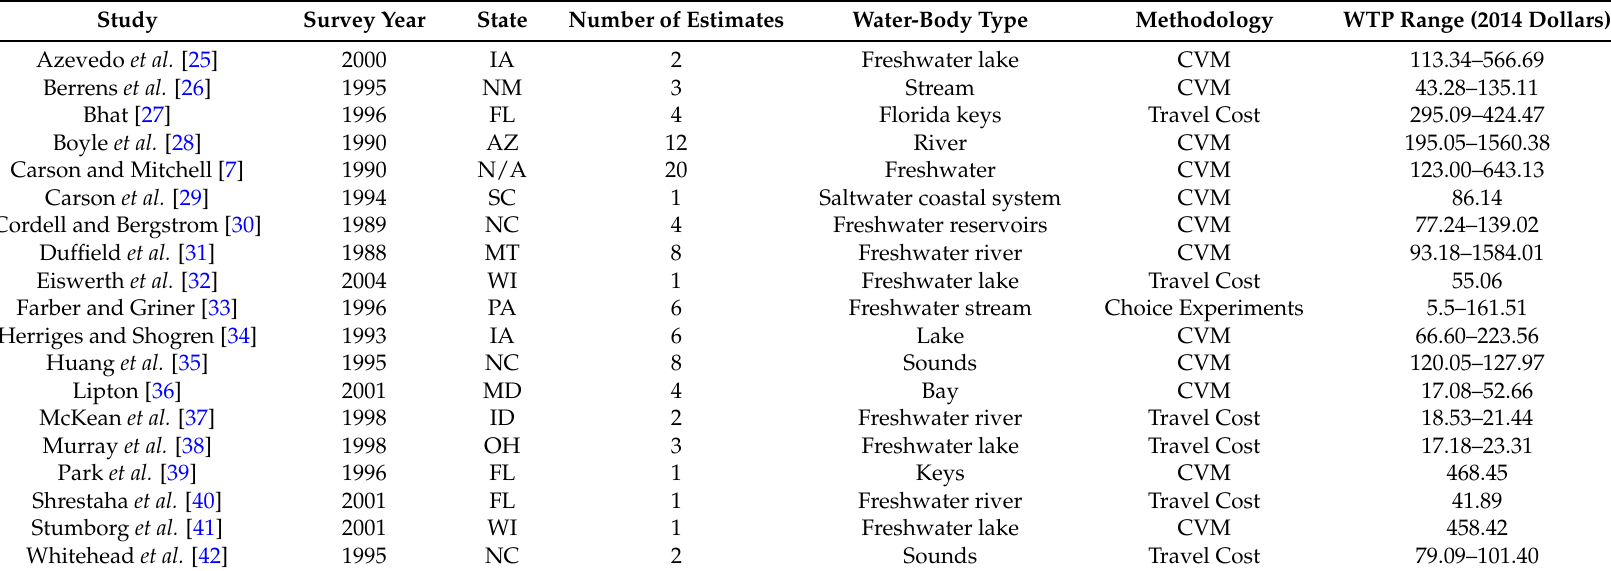
Table 1. Studies on water valuation used in